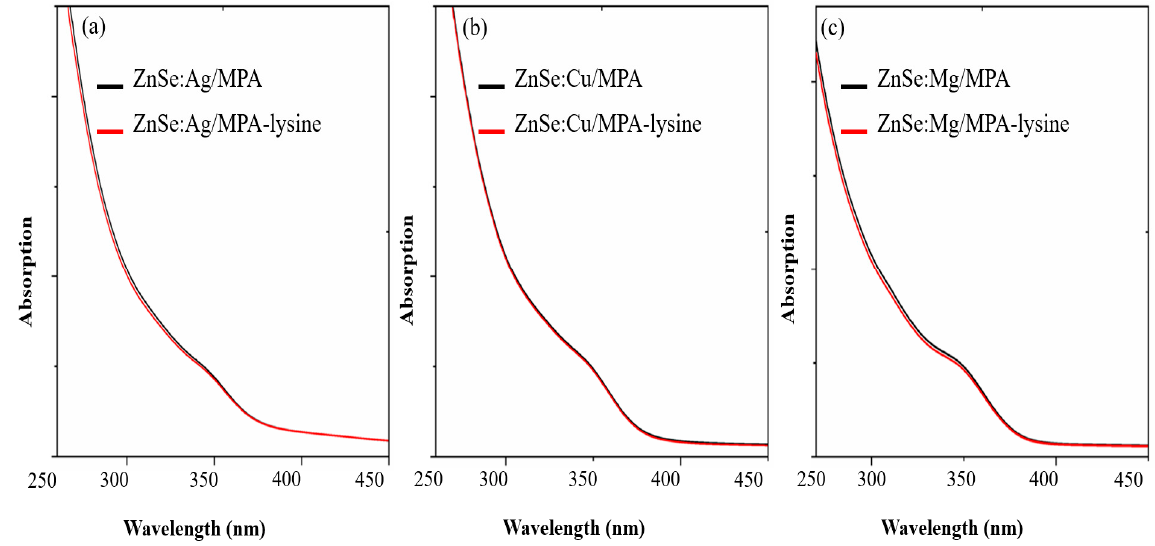
Crystals 2022 , 12 , x FOR PEER REVIEW Figure 3. The UV spectra of ZnSe:X (1%) capped with MPA and lysine. Figure 3. The UV spectra of ZnSe:X (1%) capped with MPA and lysine.